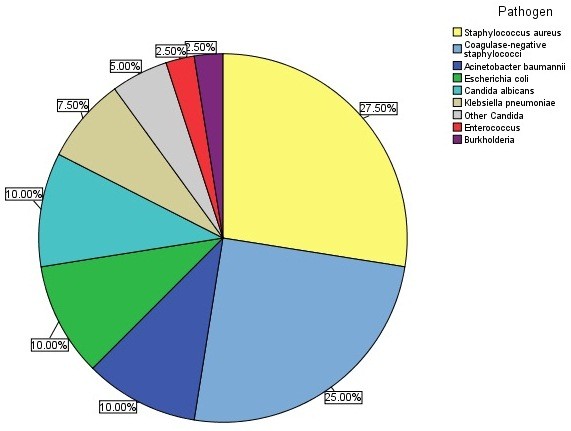
Causes of bacteremia. Shown are the relative proportions of causes of bacteremia from 33 positive blood cultures